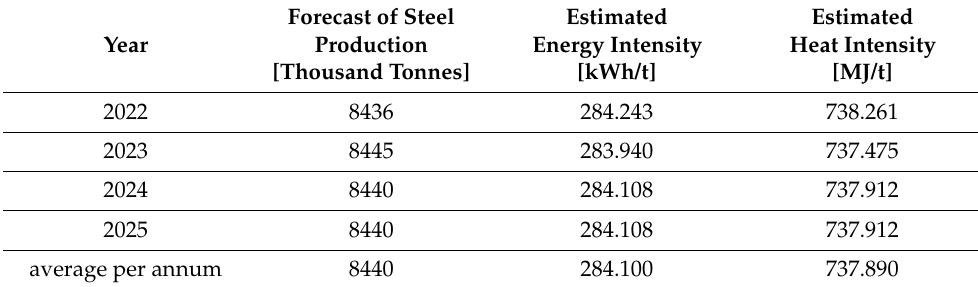
Table 3. Estimated energy and heat intensity for forecasts of steel in 2022–2025 (variant 1B).